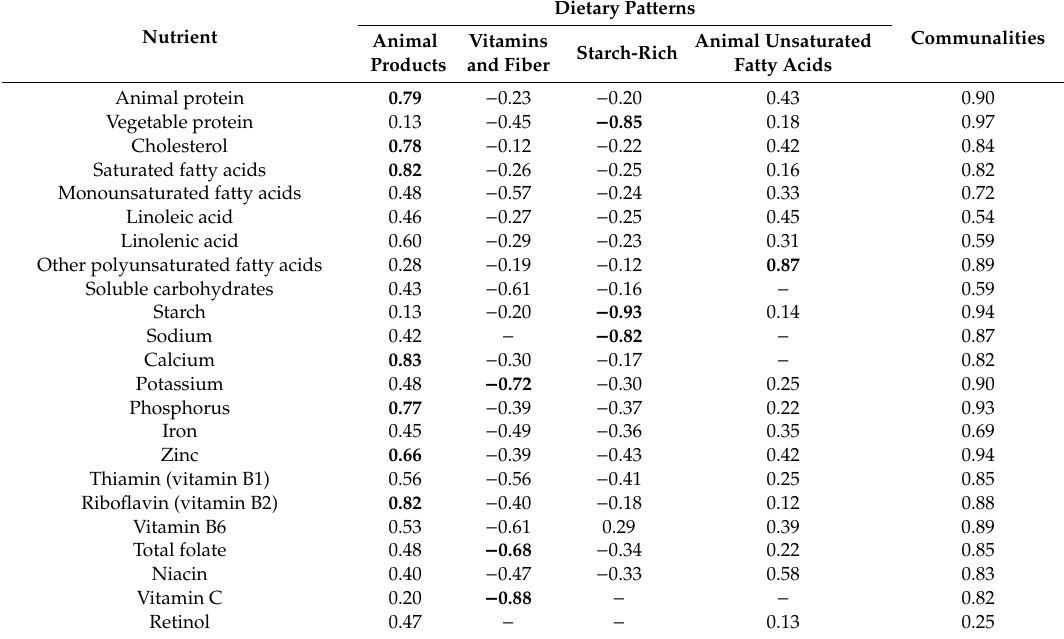
Table 2. Factor loading matrix 1 , communalities, and explained variances for the four major dietary patterns identified by principal component factor